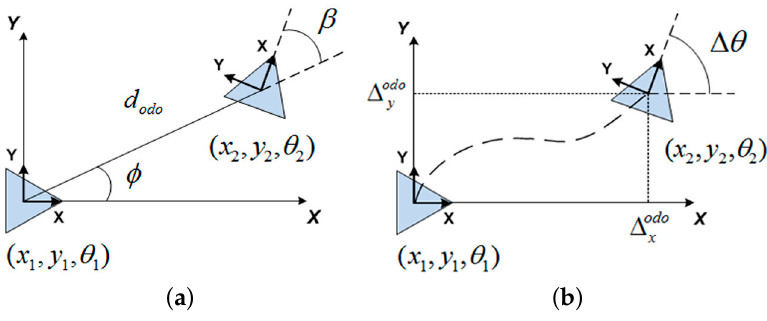
Figure 2. Visual odometry diagrams: ( a ) angular model; ( b ) differential